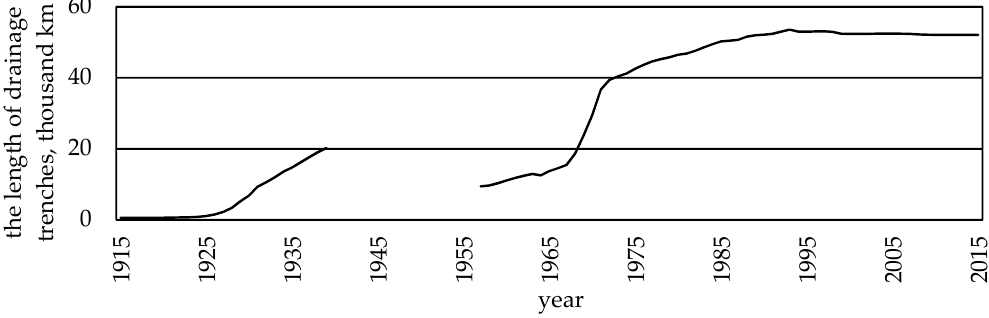
Figure 1. Dynamics in regulated stream channels and main drainage trenches in Lithuania.